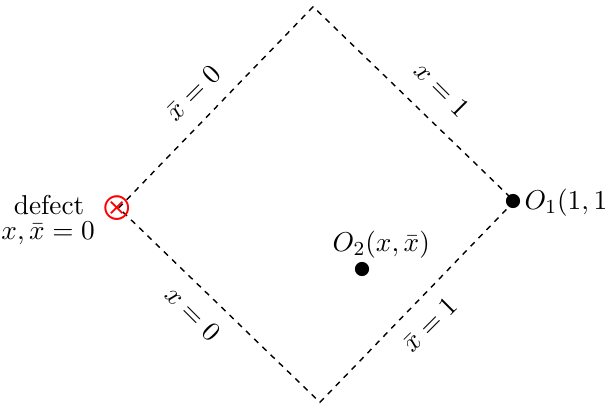
Figure 1 . Two-point function con(cid:12)guration in a plane orthogonal to the defect. The defect is at the origin while the operators O 1 and O 2 are at points (1 ; 1) and ( x; (cid:22) x ),